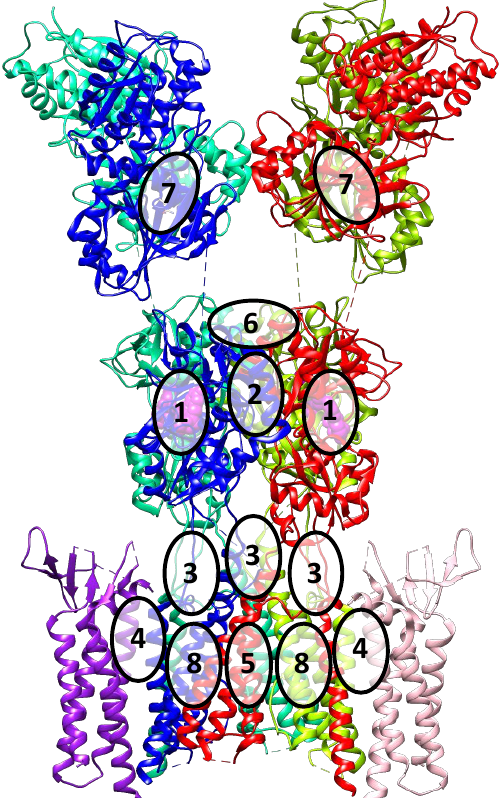
Figure 4. Various binding sites in the AMPA receptor. Similar to Figure 1, the receptor subunits (PDB: 6QKZ) are shown in blue, mint, spring green, and red, while the competitive antagonist is shown in magenta. The representative auxiliary subunits (TARP γ8) are shown in pink and purple. For the numbering of the sites, see the text.